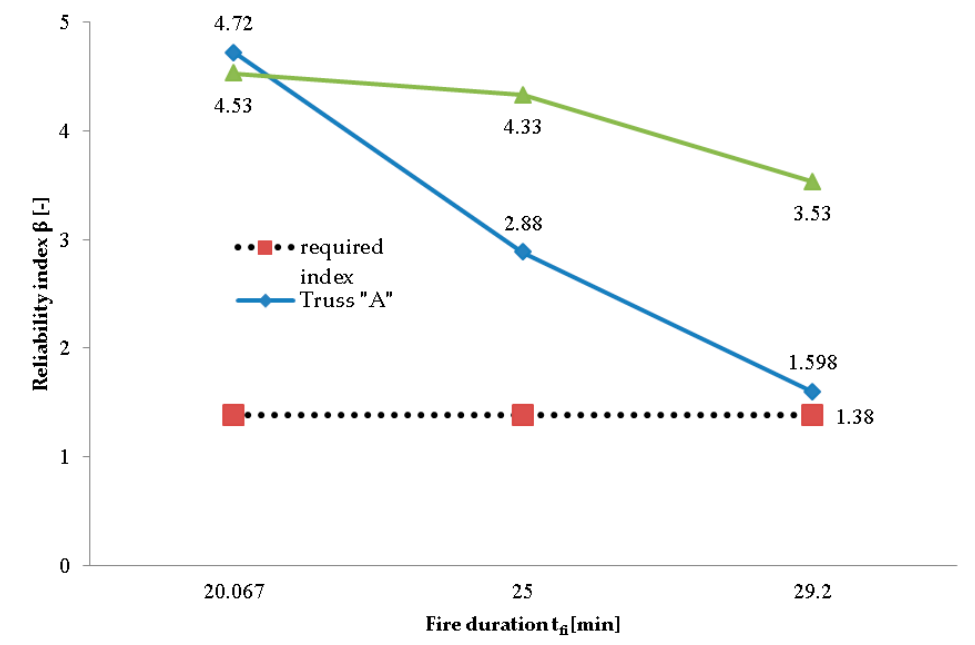
Figure 11. Change in the reliability index of truss “A”.